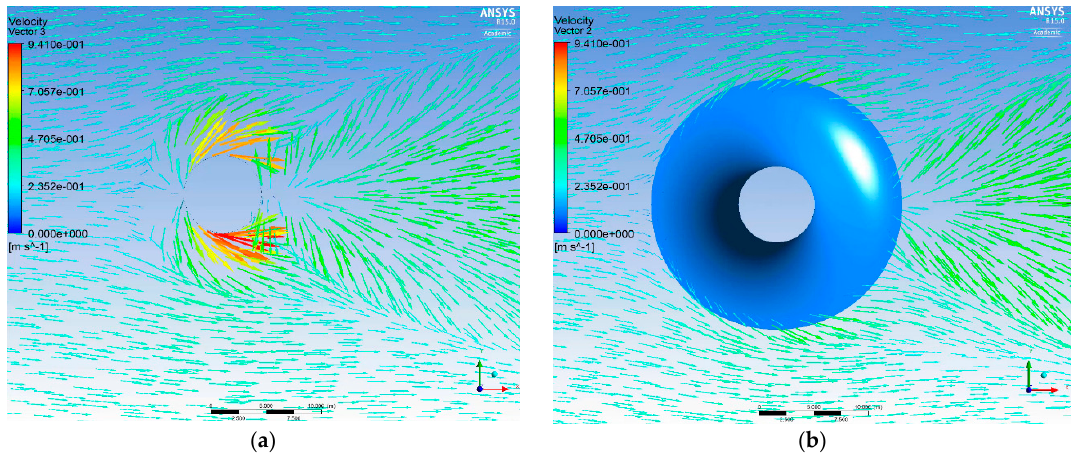
Figure 10. Velocity vectors on the 0.1m plane above the seabed: ( a ) before using the SEMCD; ( b ) after using the SEMCD.